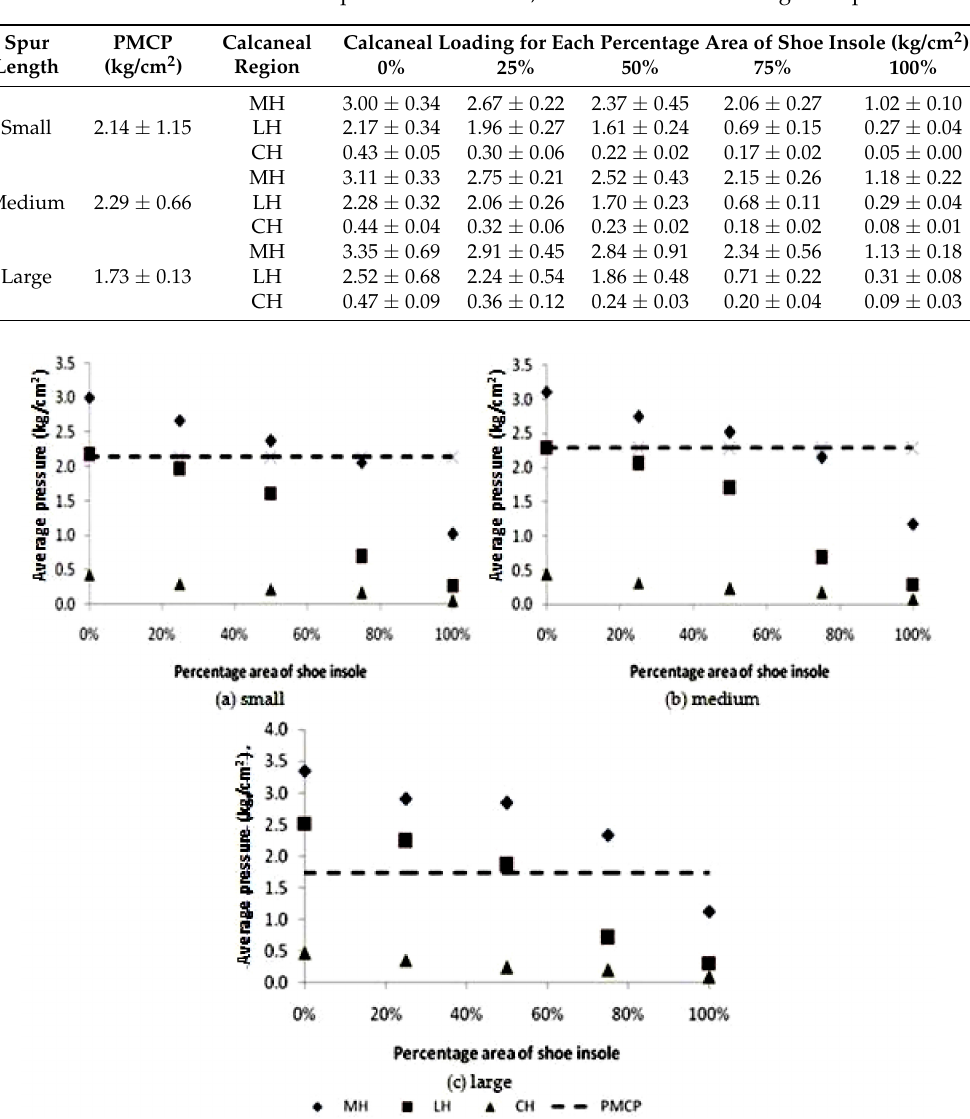
Figure 7. The pressure at the MH, LH and CH for the five percentage areas of shoe insole and each length of spur, as presented in Table